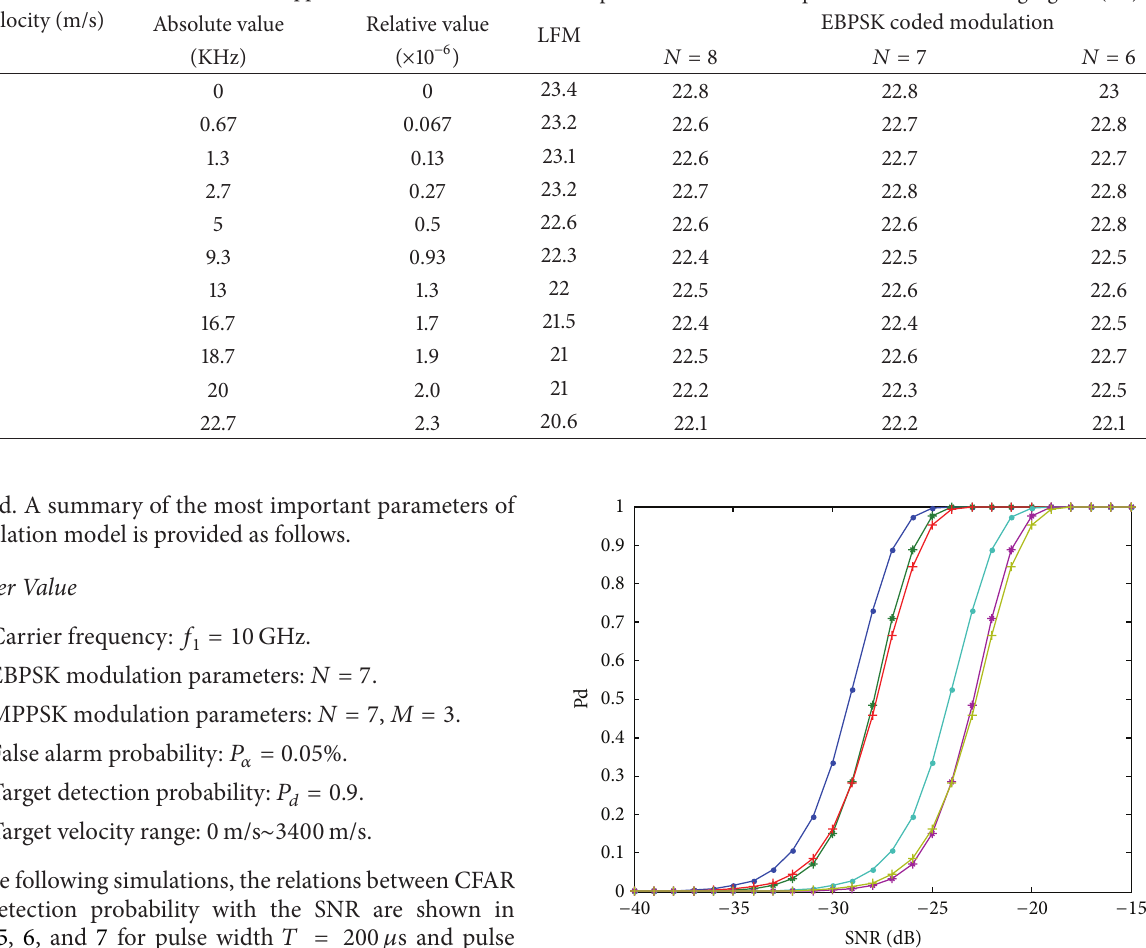
Table 1: Comparative simulation on the improved amounts of output SNR of LFM and EBPSK modulation radar systems. Target velocity (m/s)